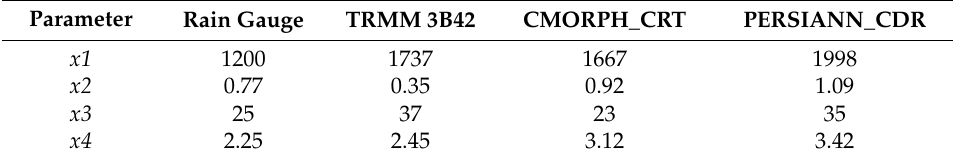
Table 3. Calibrated parameter values in the GR4J model for different precipitation data inputs. Parameter Rain